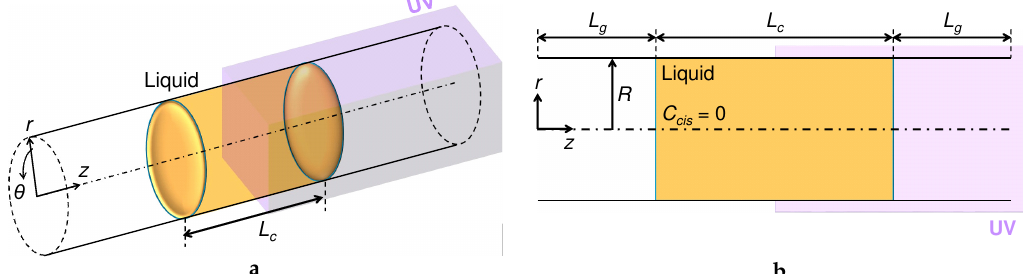
Figure 2. Coordinate system and configuration of an in-tube photoisomerizable liquid column to be irradiated partially with UV light. ( a ) Bird’s eye view; ( b ) cross-sectional view. The liquid column is initially located at the center of the tube domain and in the form of a simple column shape, being surrounded by air. The length of the liquid column is denoted as L c , while that of the gas phase is L g .